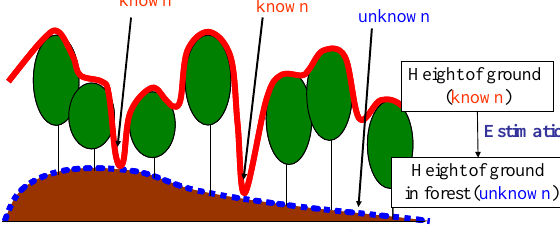
Figure 3. Concept Diagram of DTM Estimation